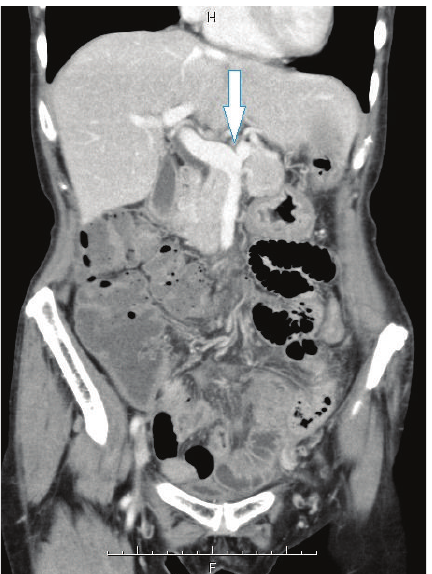
Figure 2: Contrast enhanced computed tomographic scan of the abdomen (coronal view) six days after starting anticoagulation therapy. The superior mesenteric vein is patent (arrow) and the thrombus has